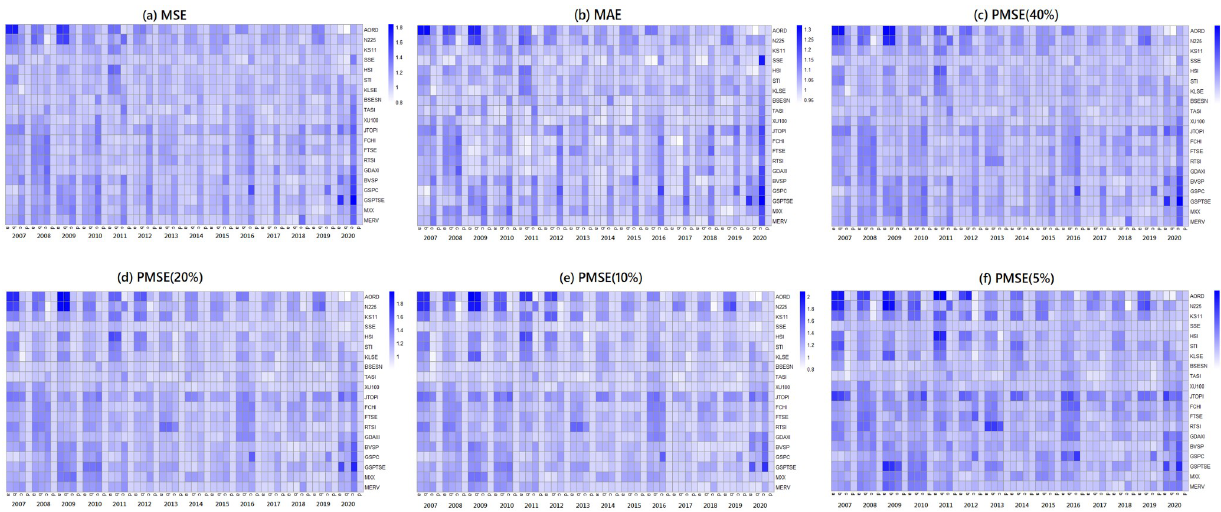
Fig 7. The prediction performances of the 4 models for the 20 indices from 2007 to